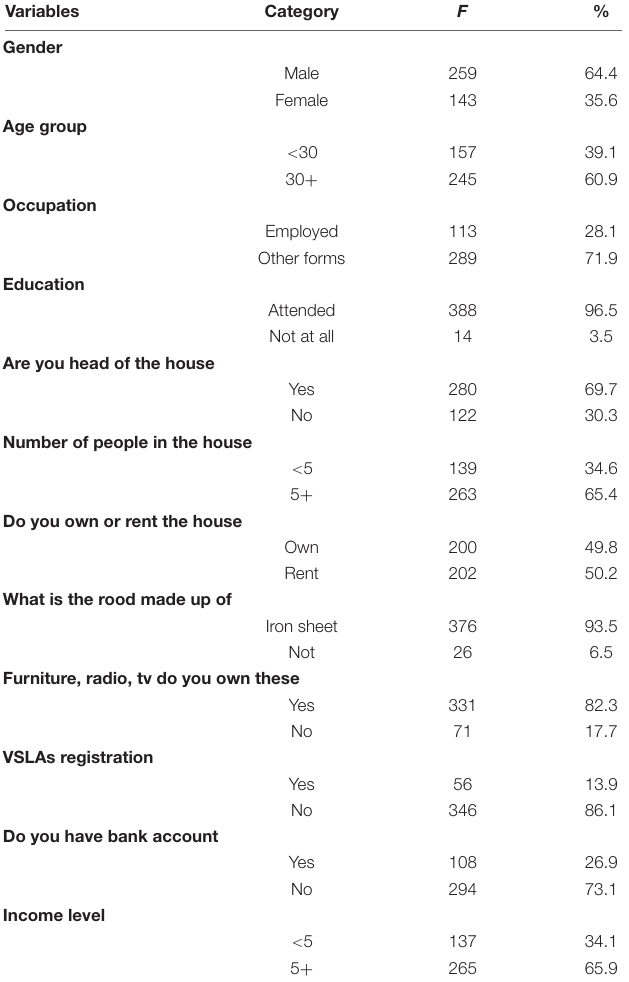
TABLE 3 | Demographic and socio-economic characteristics of the respondents ( N =